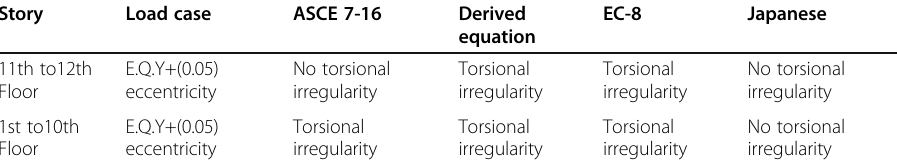
Table 8 Torsional irregularity check of 2nd and 3rd model due to ASCE 7-16, EC-8, Japanese, and derived